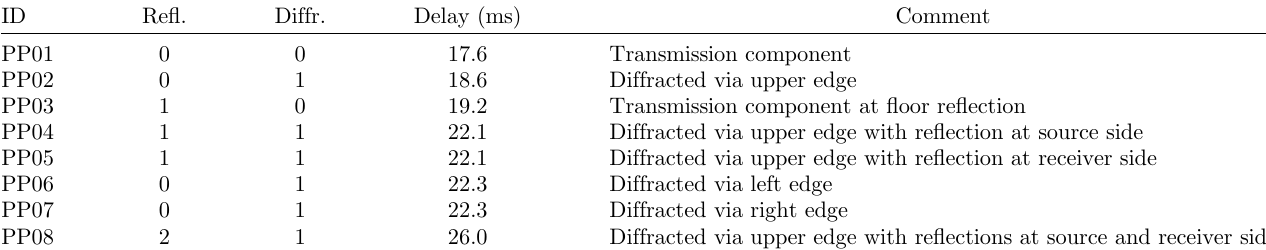
Table 3. Geometrical propagation paths of BRAS scene 5 (LS01, MP01) [46] ordered by time of arrival.